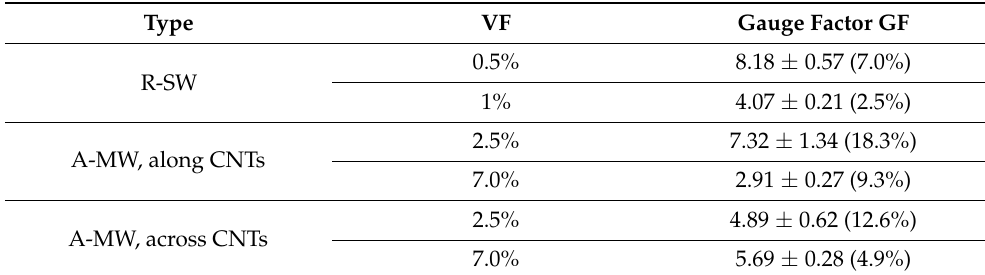
Table 4. Gauge factors, Equation (5), for unidirectional tension deformation 0.01 in Z-direction, the